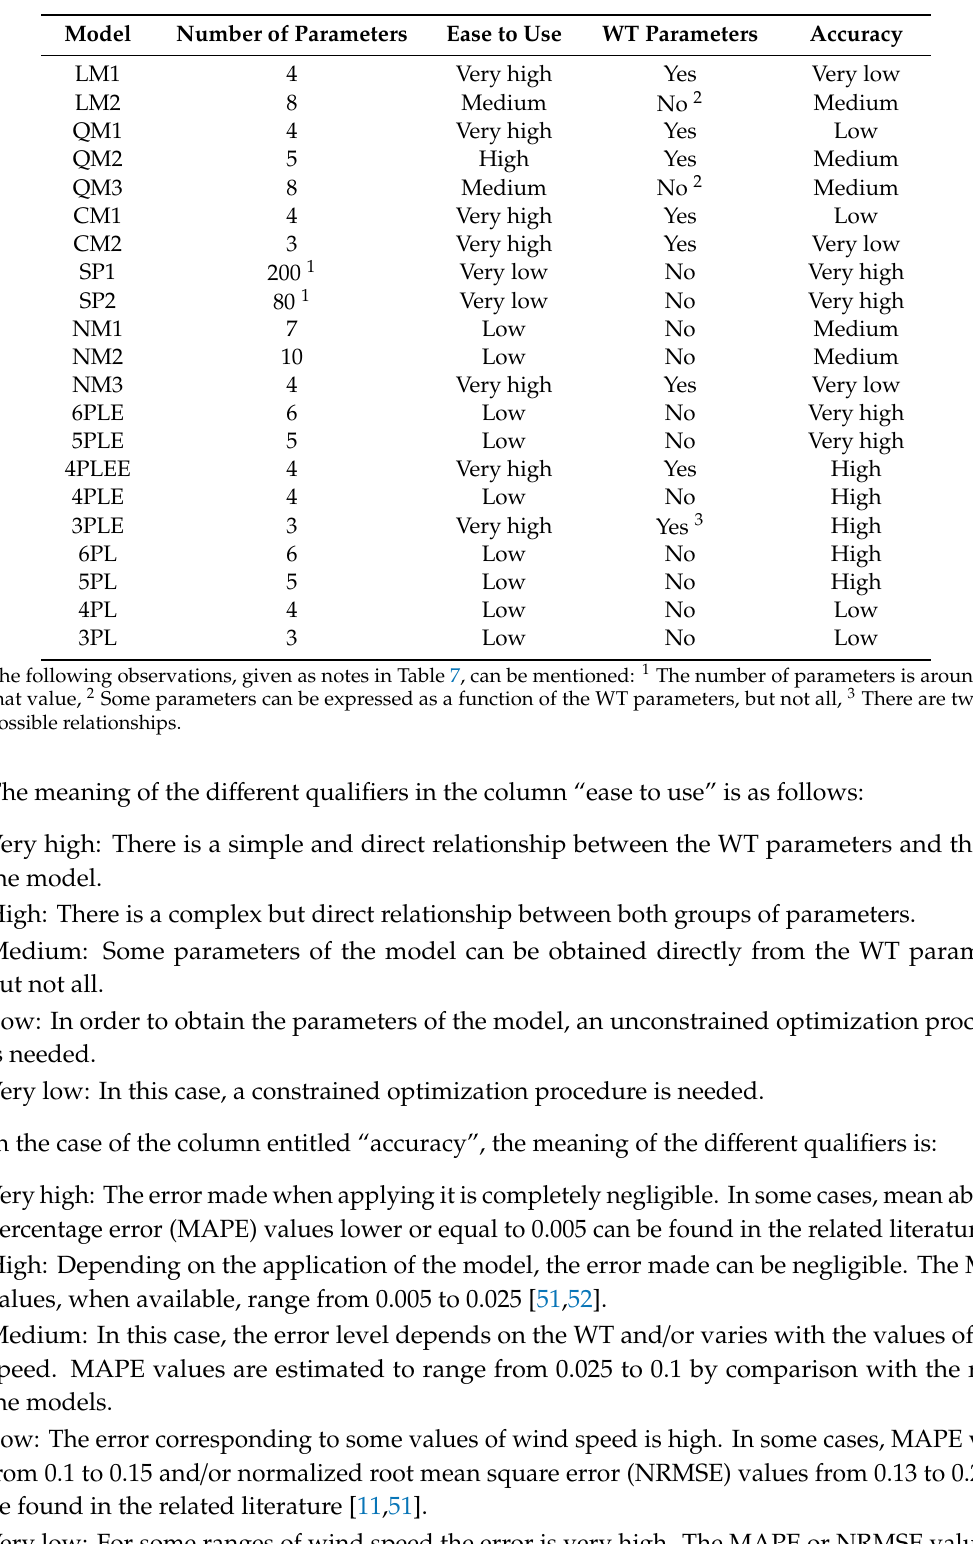
Table 7. Assessment of the WT power curves